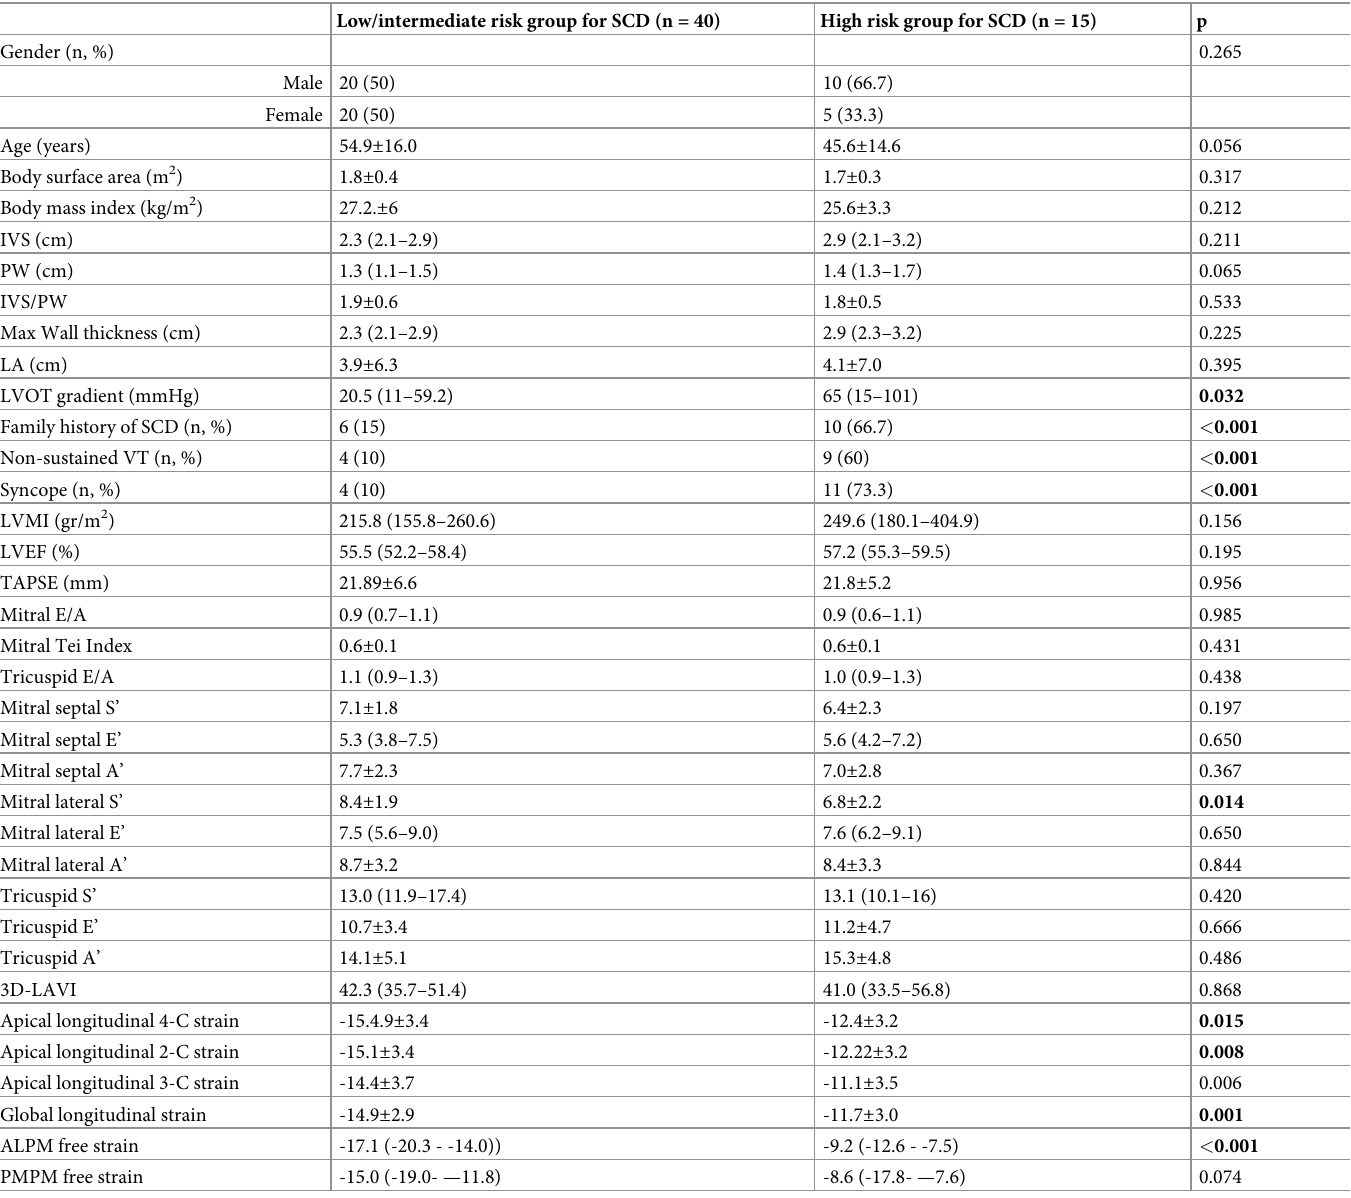
Table 2. Comparison of the patients with low and high SCD risk score. Low/intermediate risk group for SCD (n =